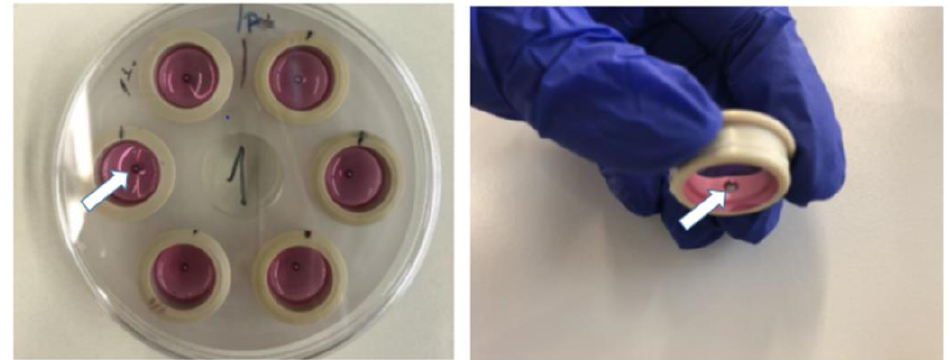
Figure 1. Representation of the 6-channel CellDrum holder used (left). Each individual CellDrum was filled with DMEM (pink-colored), and the steel balls were placed (white arrows) in the middle of the membranes (right).